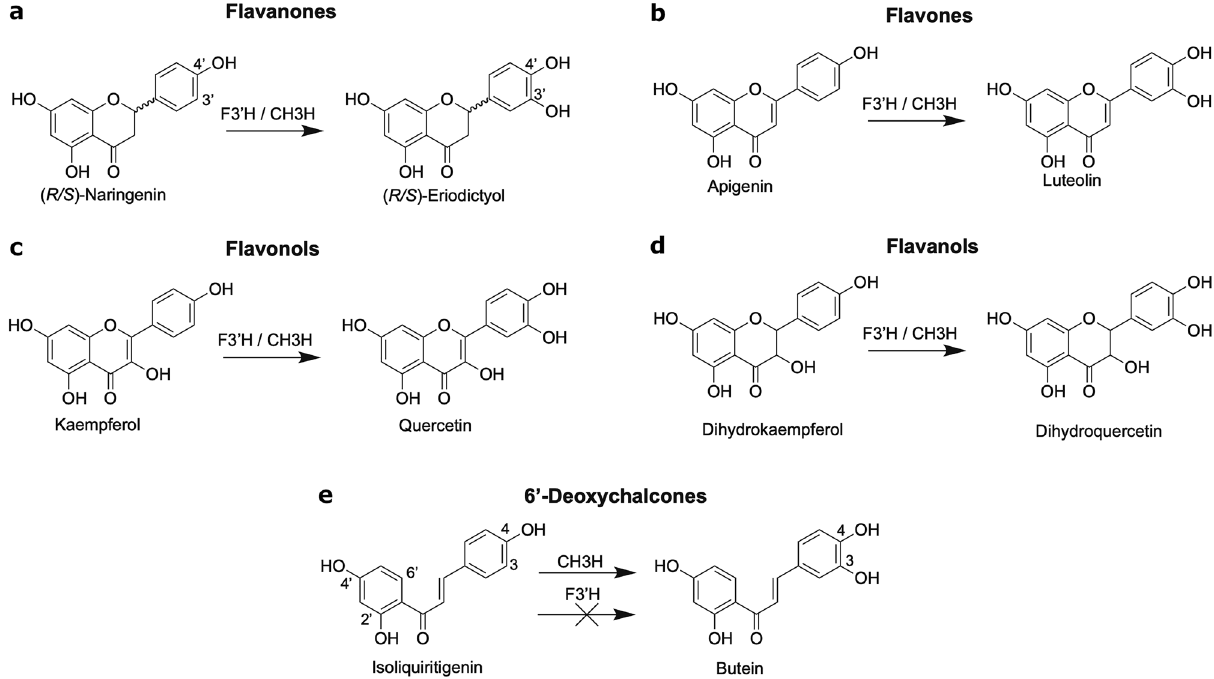
Figure 1. Reactions catalysed by chalcone 3-hydroxylase and flavonoid 3 ′